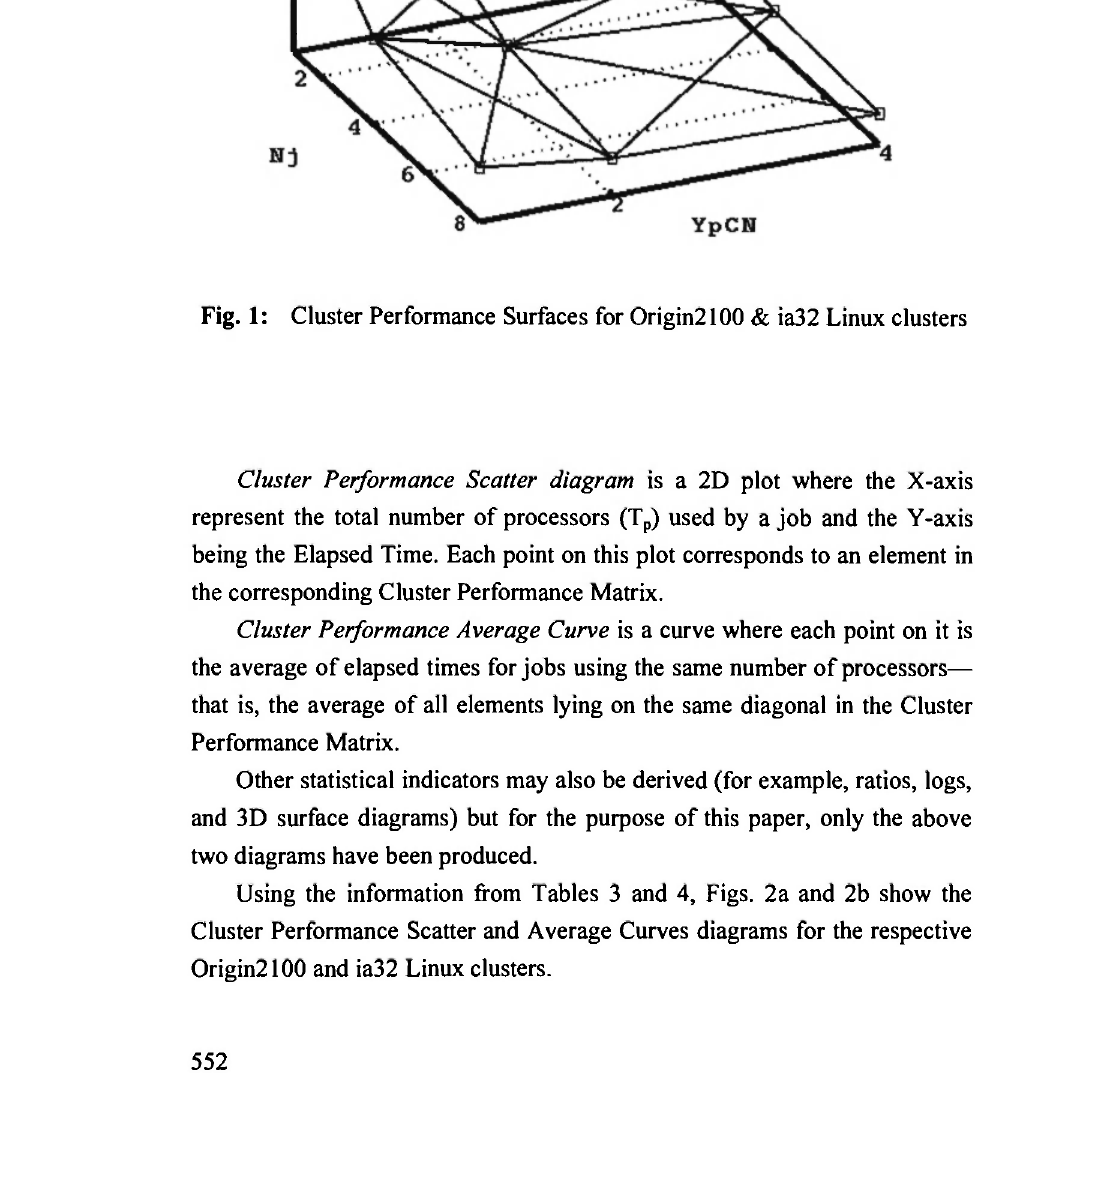
Fig. 1: Cluster Performance Surfaces for 0rigin2100 & ia32 Linux clusters